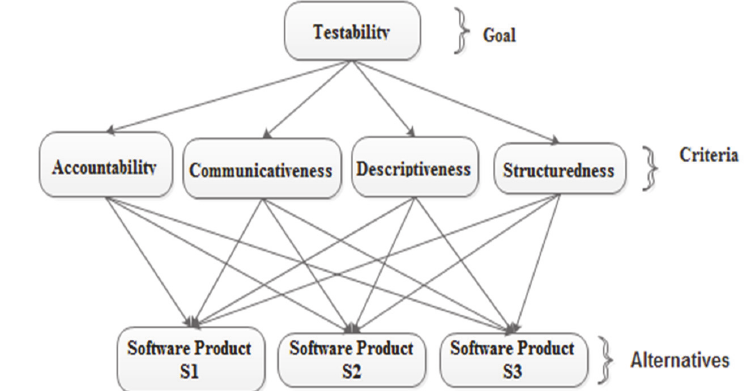
Fig. 7. Hierarchical Structure of